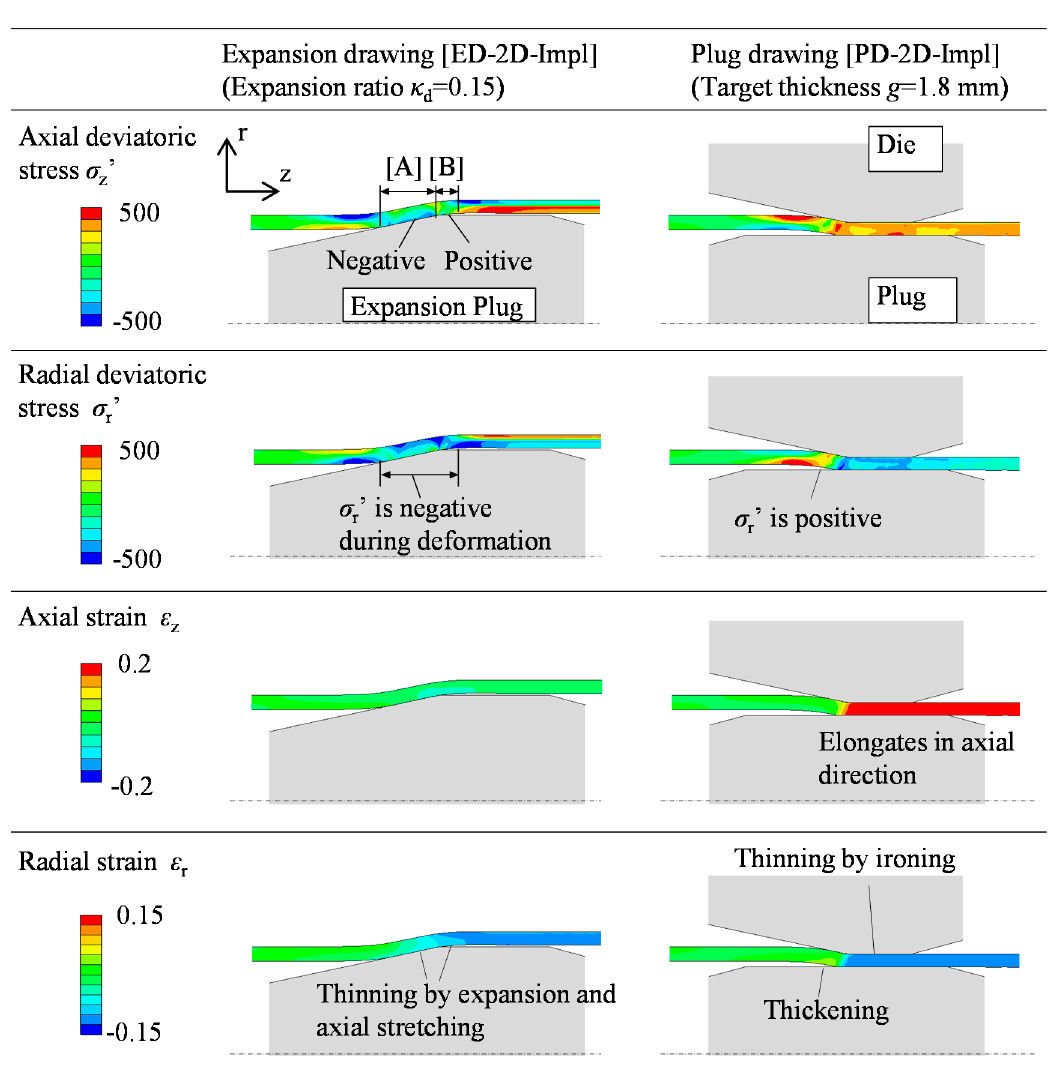
Figure 13. Distributions of deviatoric stress σ z ’ and σ r ’ and strain ε z and ε r for each drawing process (initial tube thickness, t 0 = 2 mm).